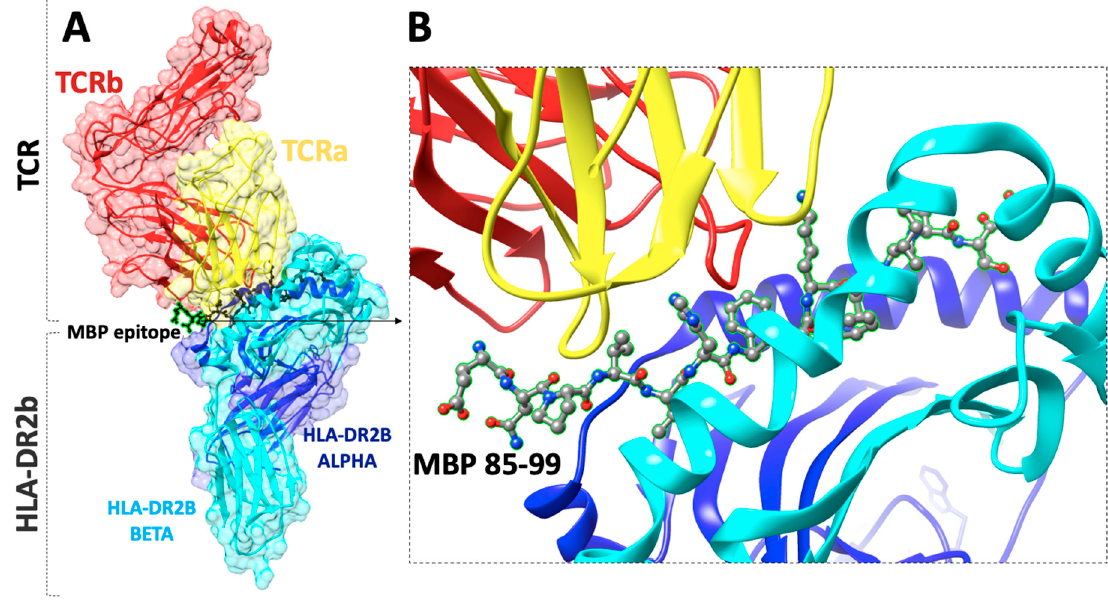
Figure 2. ( A ) The X-ray structure (pdb: 1YMM) of a human autoimmune TCR bound to a myelin basic protein (MBP 85–99 ) peptide and a MS-associated MHC class II molecule (HLA-DR2b), ( B ) close view of the docking site of (MBP 85–99 ) peptide.